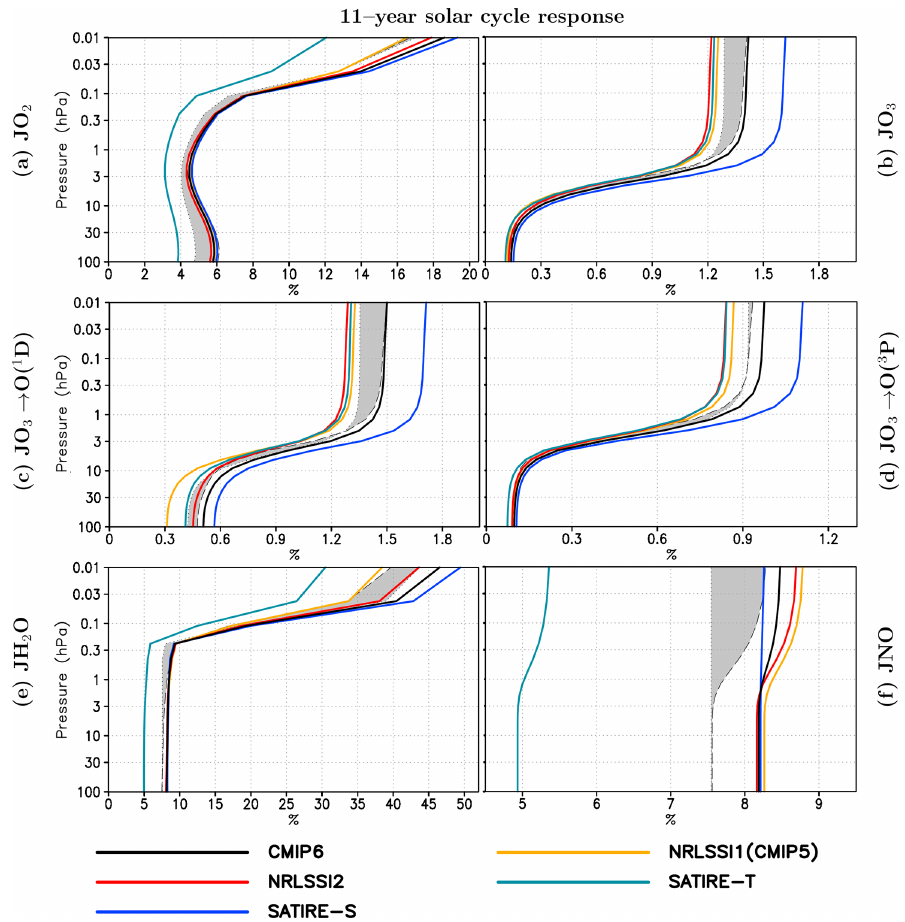
Figure 6. Percentage change of the photolysis rates from solar minimum to maximum of (a) oxygen ( J O 2 ), (b) ozone ( J O 3 = J O 3 → O ( 1 D ) + J O 3 → O ( 3 P ) ), (c) O 3 -producing O ( 1 D ) ( J O 3 → O ( 1 D ) ), (d) O 3 -producing O ( 3 P ) ( J O 3 → O ( 3 P ) ), (e) water vapour (JH 2 O), and (f) nitric oxide ( J NO) for a single time step at 180 ◦ E averaged from 60 ◦ S to 60 ◦ N. Changes are derived for an average of WACCM and EMAC simulations using five SSI data sets at solar maximum NRLSSI1(CMIP5) (yellow), NRLSSI2 (red), SATIRE-S (blue), SATIRE-T (dark blue), and CMIP6 (black) relative to the average of the WACCM and EMAC reference solar minimum simulations. The shaded area indicates the range of the WACCM (long black dashed contour) and EMAC (black dotted contour) ensemble